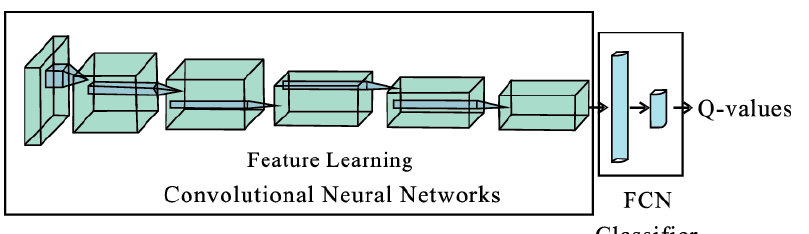
Figure 3. Main structure of two reinforcement learning agents DQN-CNN and DQN-1D-CNN. For DQN- CNN, the structure of the feature learning part is CNN. For DQN-1D-CNN, the structure of the feature learning part is 1D-CNN. FCN represents the fully connected